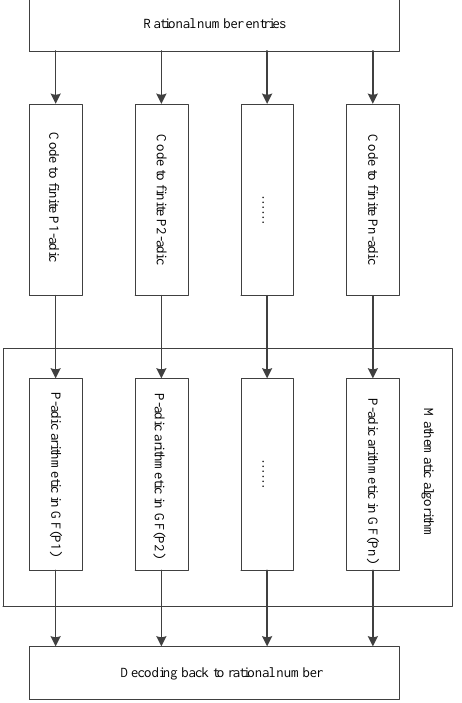
Fig. 2. Extended CRT combined with P-adic arithmetic for parallel implementation The decoding